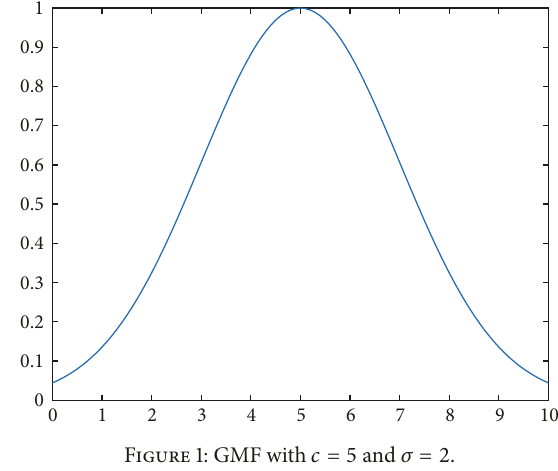
Figure 1: GMF with 𝑐 = 5 and 𝜎 = 2